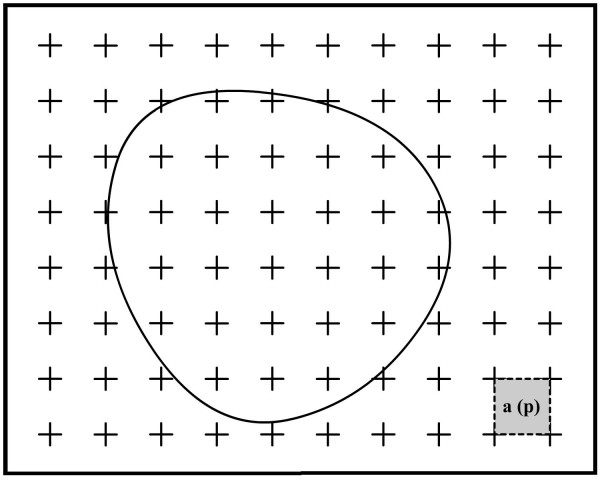
The point counting method for estimation of the cross section area of sciatic nerve. The profile area of nerve can be estimated by placing a tested point grid on the profile of nerve. The number of points, P, that hits the profile area multiplied by the area associated with each grid point, a(p), is an unbiased estimate of cross section area of nerve. A = a (p)·ΣP. The same approach can be also used for estimation of cross section area of axon.